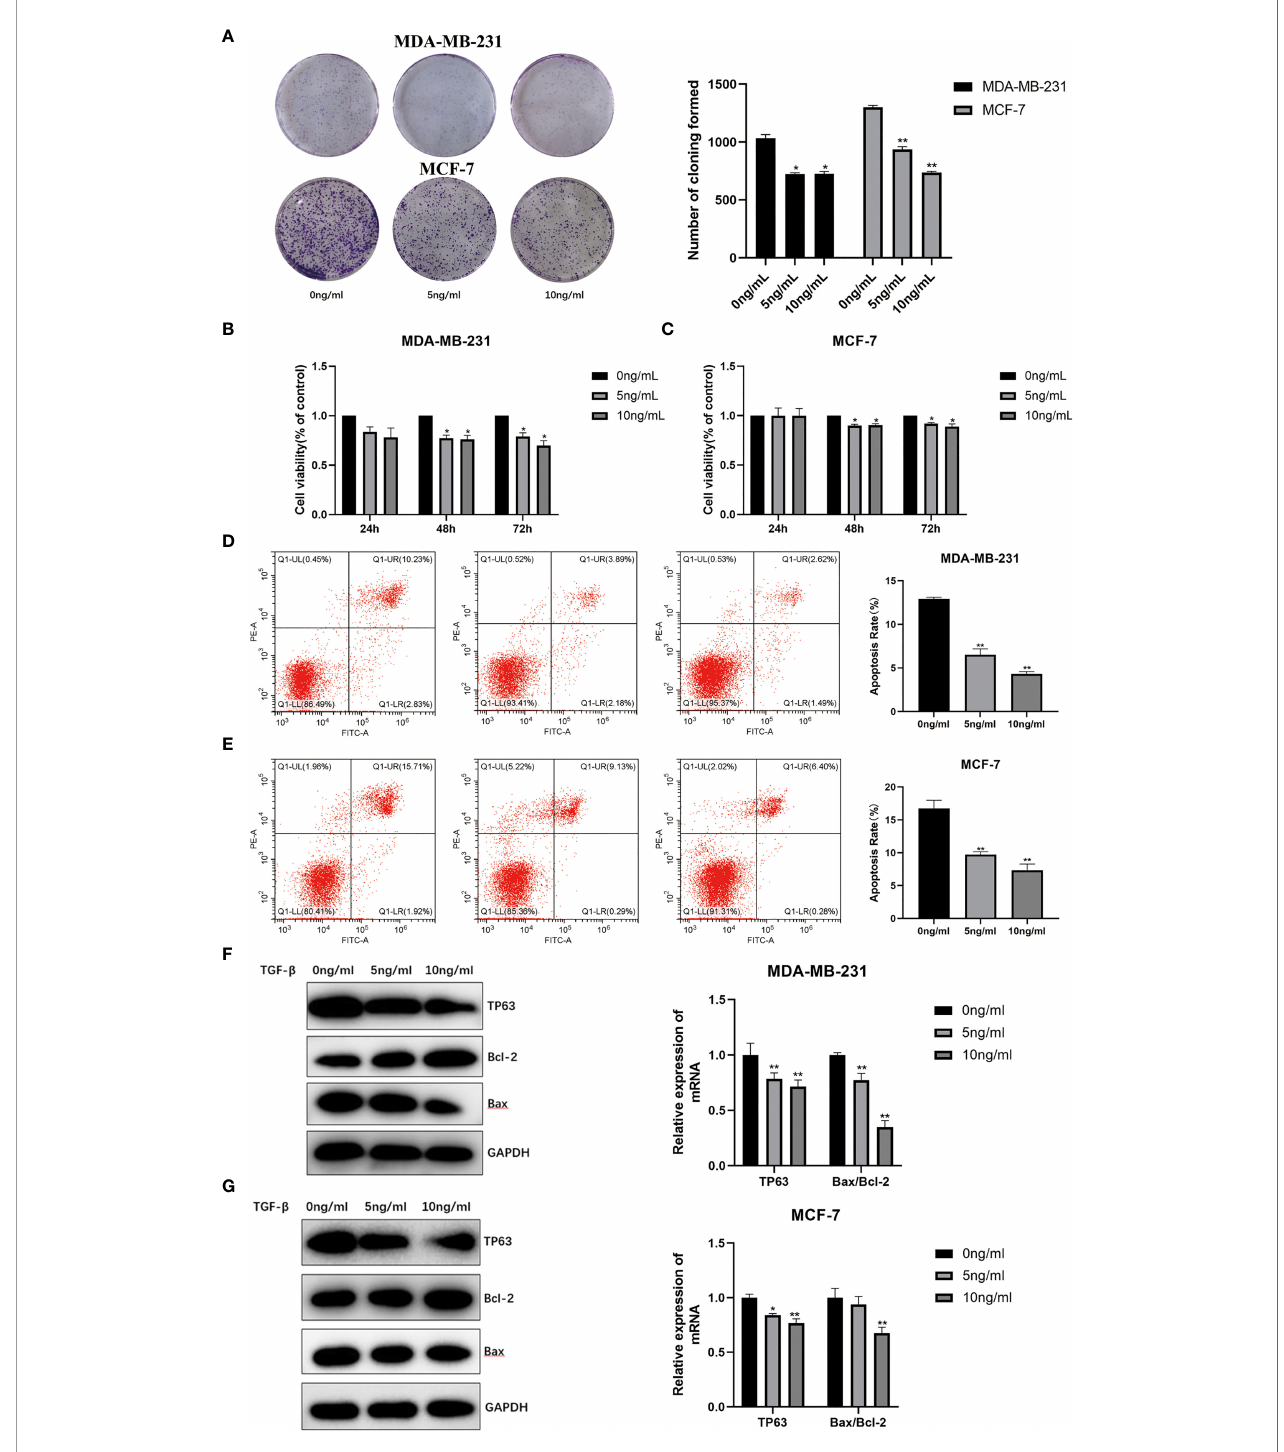
FIGURE 5 | (A) Proliferation ability of MDA-MB-231 and MCF-7 induced by TGF- b 1 by plate cloning experiment. The effect of TGF- b 1 on the proliferation of MDA- MB-231 cells (B) and MCF-7 (C) cells were analyzed by CCK-8 (*p < 0.05, **p < 0.01). Analysis of the effect of TGF- b 1 on the apoptosis of MDA-MB-231 cells (D) and MCF-7 (E) cells by Annexin V-FITC/PI stain fl ow cytometry (*p < 0.05, **p < 0.01). The expression level of the apoptosis and TP63 proteins in MDR-MB-231 cells (F) and MCF-7 (G) cells with TGF- b 1 induced. GAPDH was used as an internal control. Quantitative analysis of TP63, Bcl-2 and Bax are expressed as the mean ± SD. *, **p < 0.01 vs. control